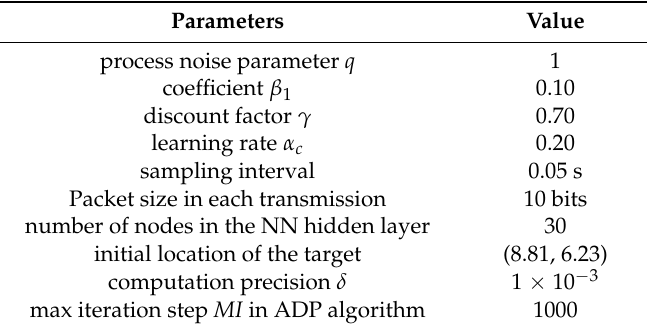
Table 2. Simulation